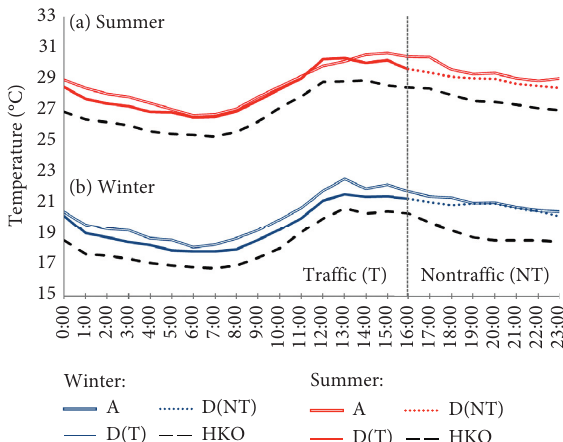
Figure 5: (a) Summer and (b) winter average temperature (hourly) measurements at point A (full-time traffic) and point D (part-time Pedestrian Street). Point A is illustrated by a double line, and point D is separated into two parts: traffic (solid line) and nontraffic periods (dotted line). The official urban (HKO) data from official urban weather stations is shown as a black dash. Table 2: A statistical summary of point A and point D under different time scenarios in both seasons, compared against the official urban HKO. This allowed us to remove background climatic effects (urban temperature difference).